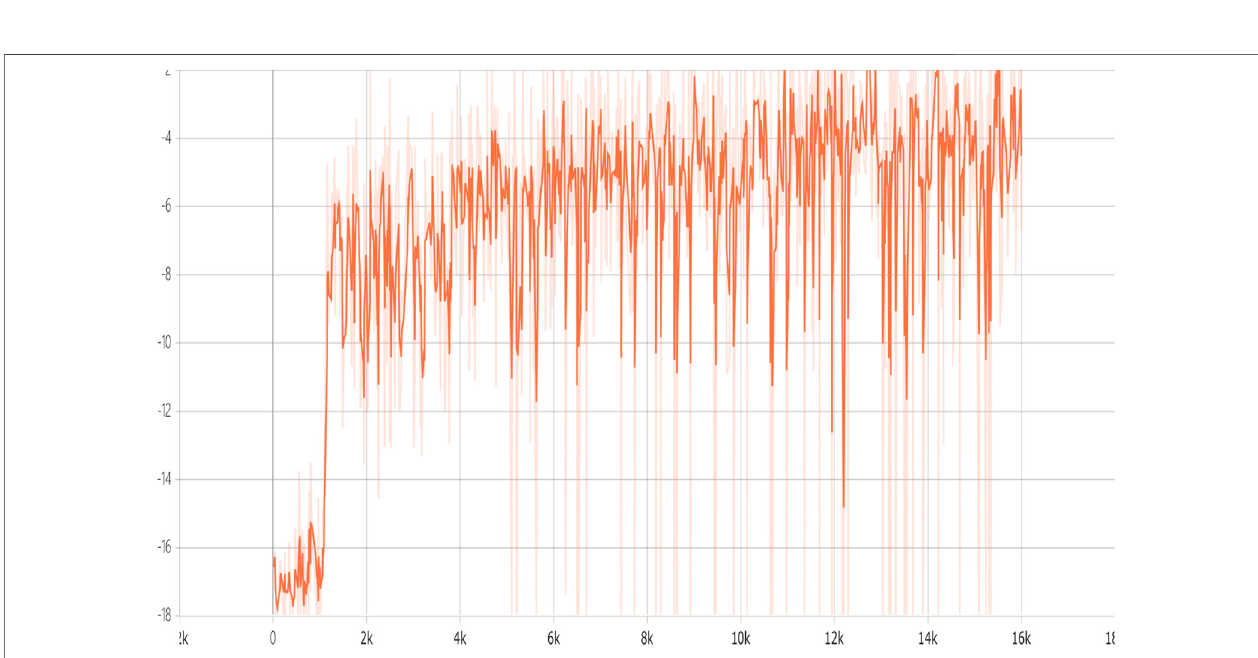
FIGURE 5 | Accumulated reward versus training episodes of